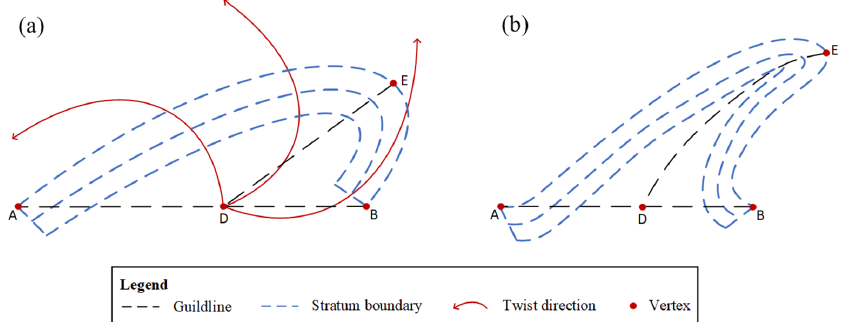
Figure 8. Distortion treatment for overturned folds: ( a ) before distortion and ( b ) after distortion.